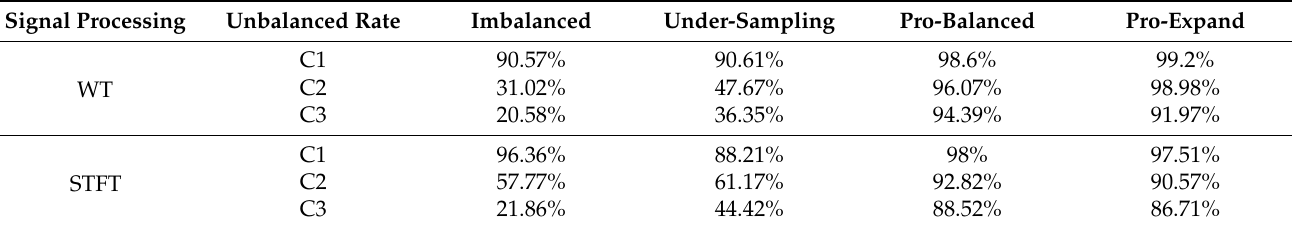
Table 9. Comparison of different signal processing and data imbalance.